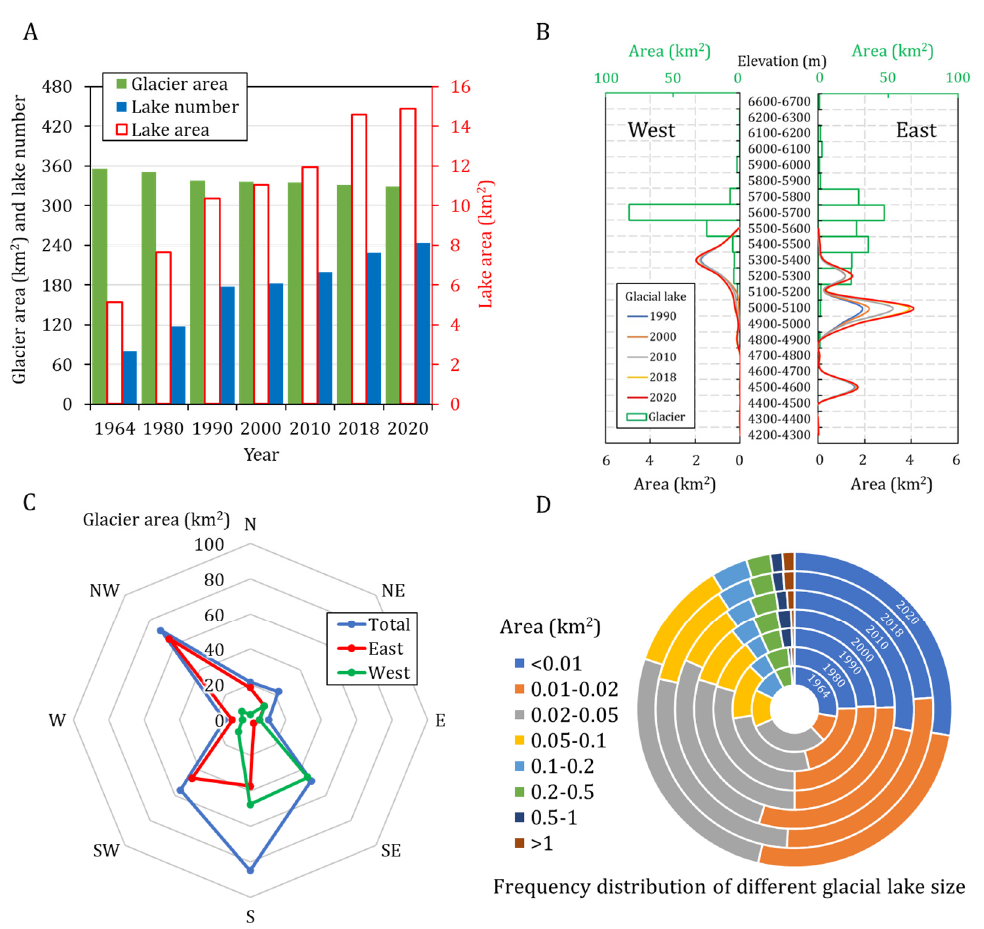
Figure 2. Overview of glaciers and glacial lakes. ( A ) Number and area changes of glaciers and glacial lakes from 1964 to 2020. ( B ) Elevation distribution of glaciers (in 2020) and glacial lakes (between 1990 and 2020) on the west and east side of the basin. ( C ) Glacier distribution with aspect in the total (blue), east (red), and west (green) of the basin. ( D ) Frequency of glacial lakes in various size classes.